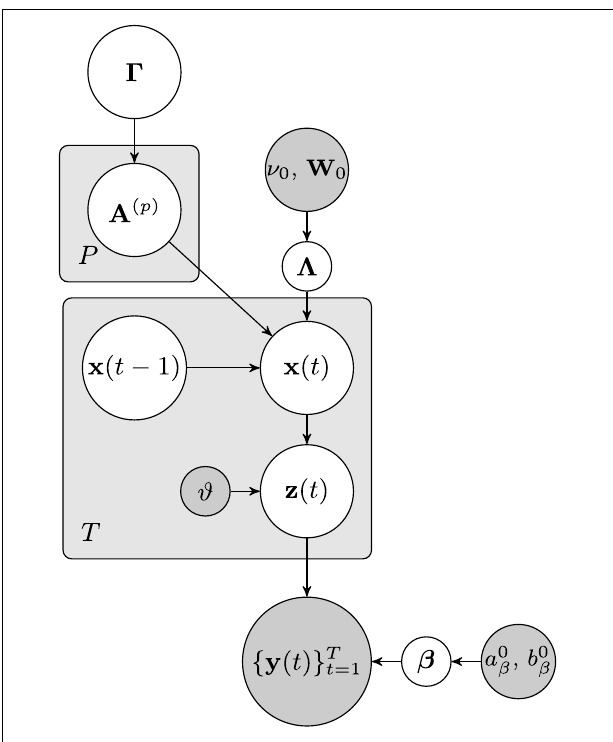
FIGURE 1 | Graphical model visualizing the dependencies of the joint distribution over the latent variables and the fMRI observations. Nodes representing latent variables are depicted with white backgrounds while nodes with known quantities have gray backgrounds. Rectangular plates indicate the repetition of